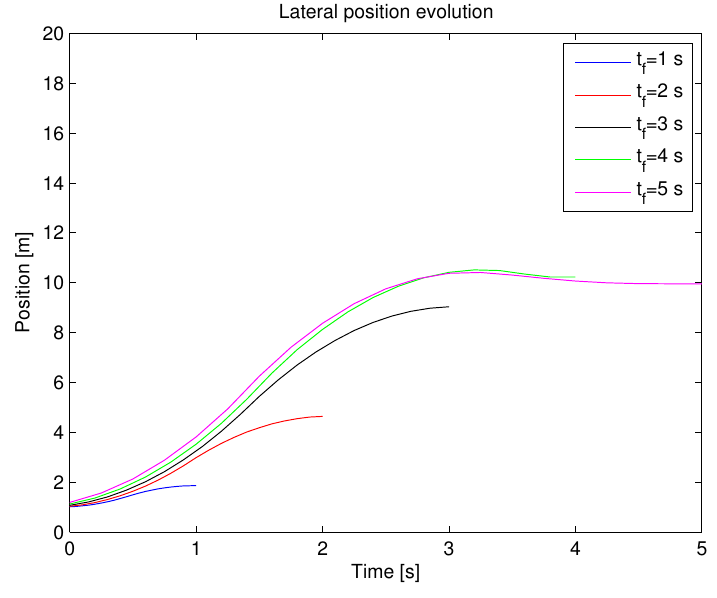
for different t D 3